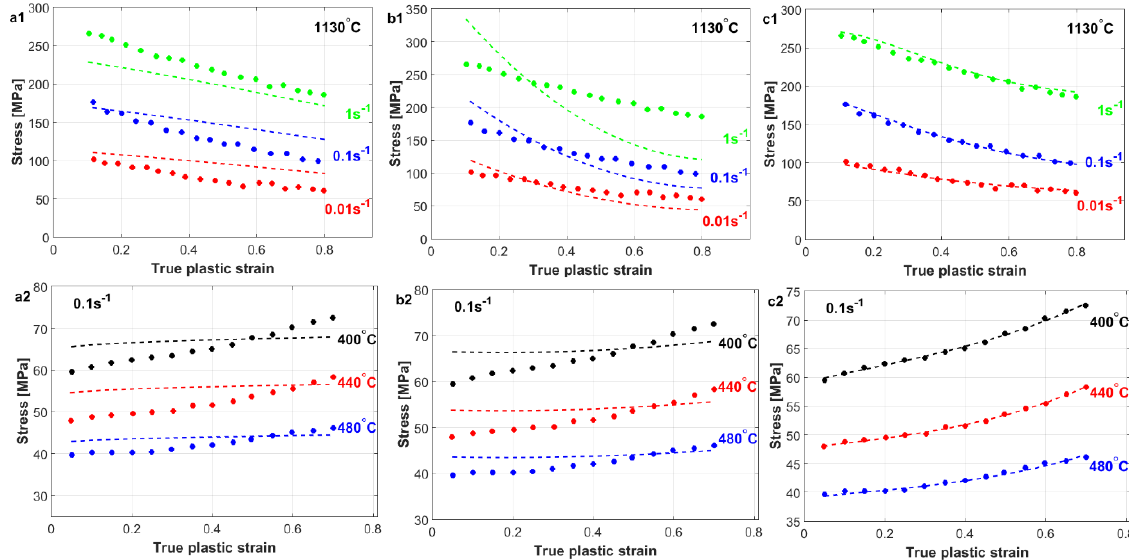
Figure 51. Comparison between experimental stresses (markers) and predicted stresses (solid lines) for U720LI (first raw) and AA7020 (second raw) alloys obtained using ( a1 , a2 ) the original JC model, ( b1 , b2 ) the modified JC model that was presented by Lin et al. [73], and ( c1 , c2 ) the improved generic modified JC model that was presented by Shokry et al. [96].